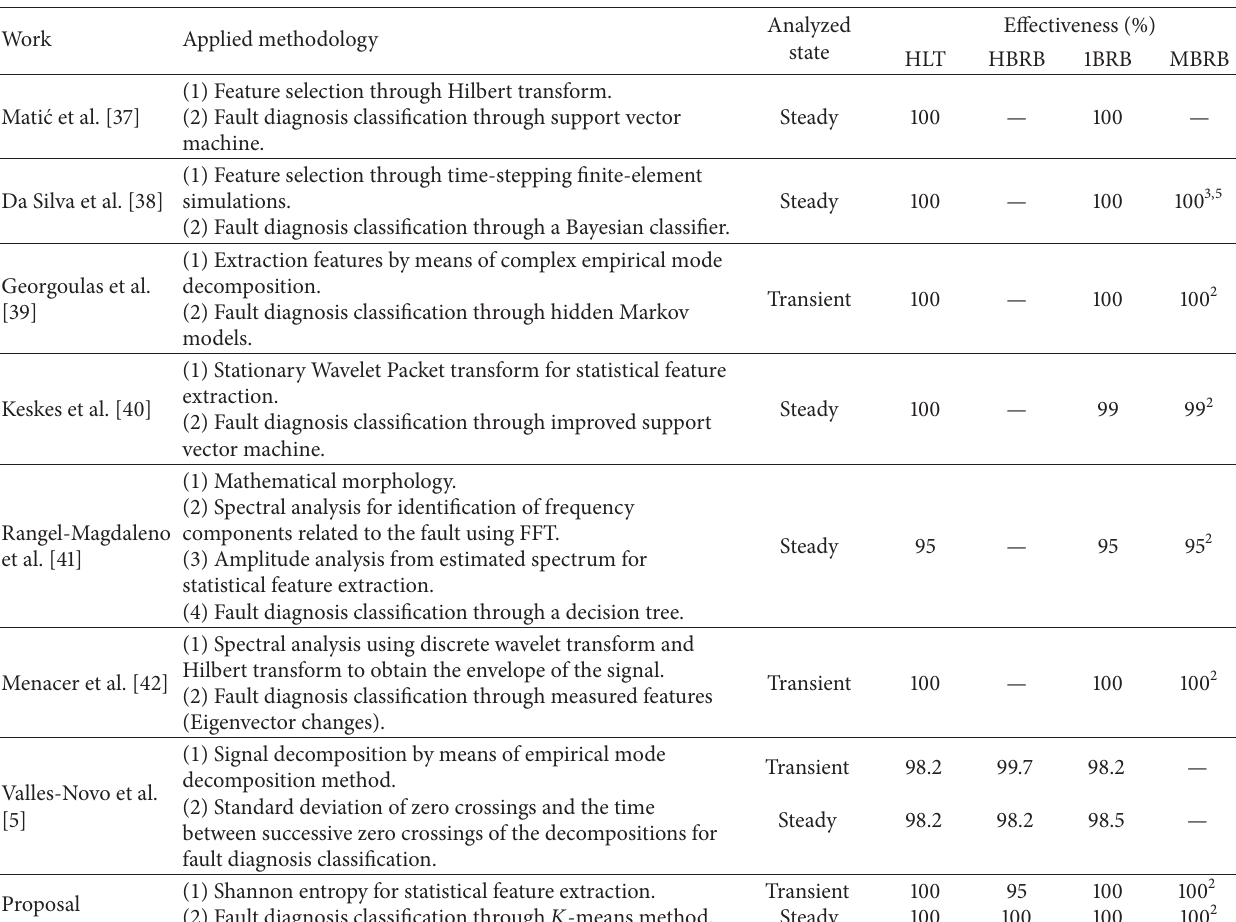
Table 6: Results and characteristics of previous works and of the proposed work.